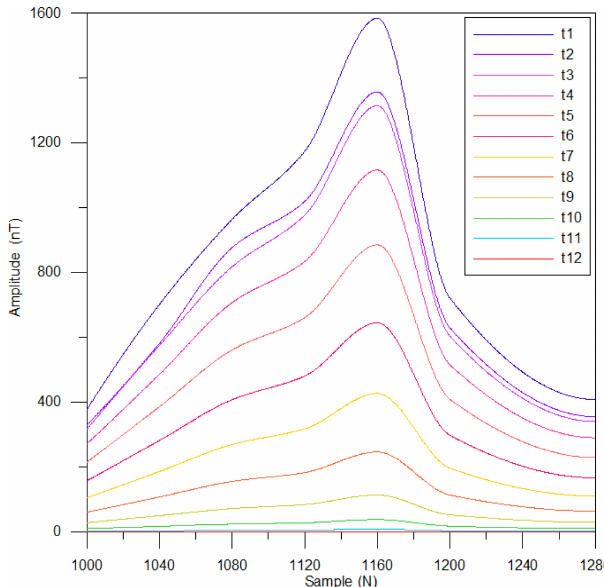
Figure 18. Survey line profile of mining area.